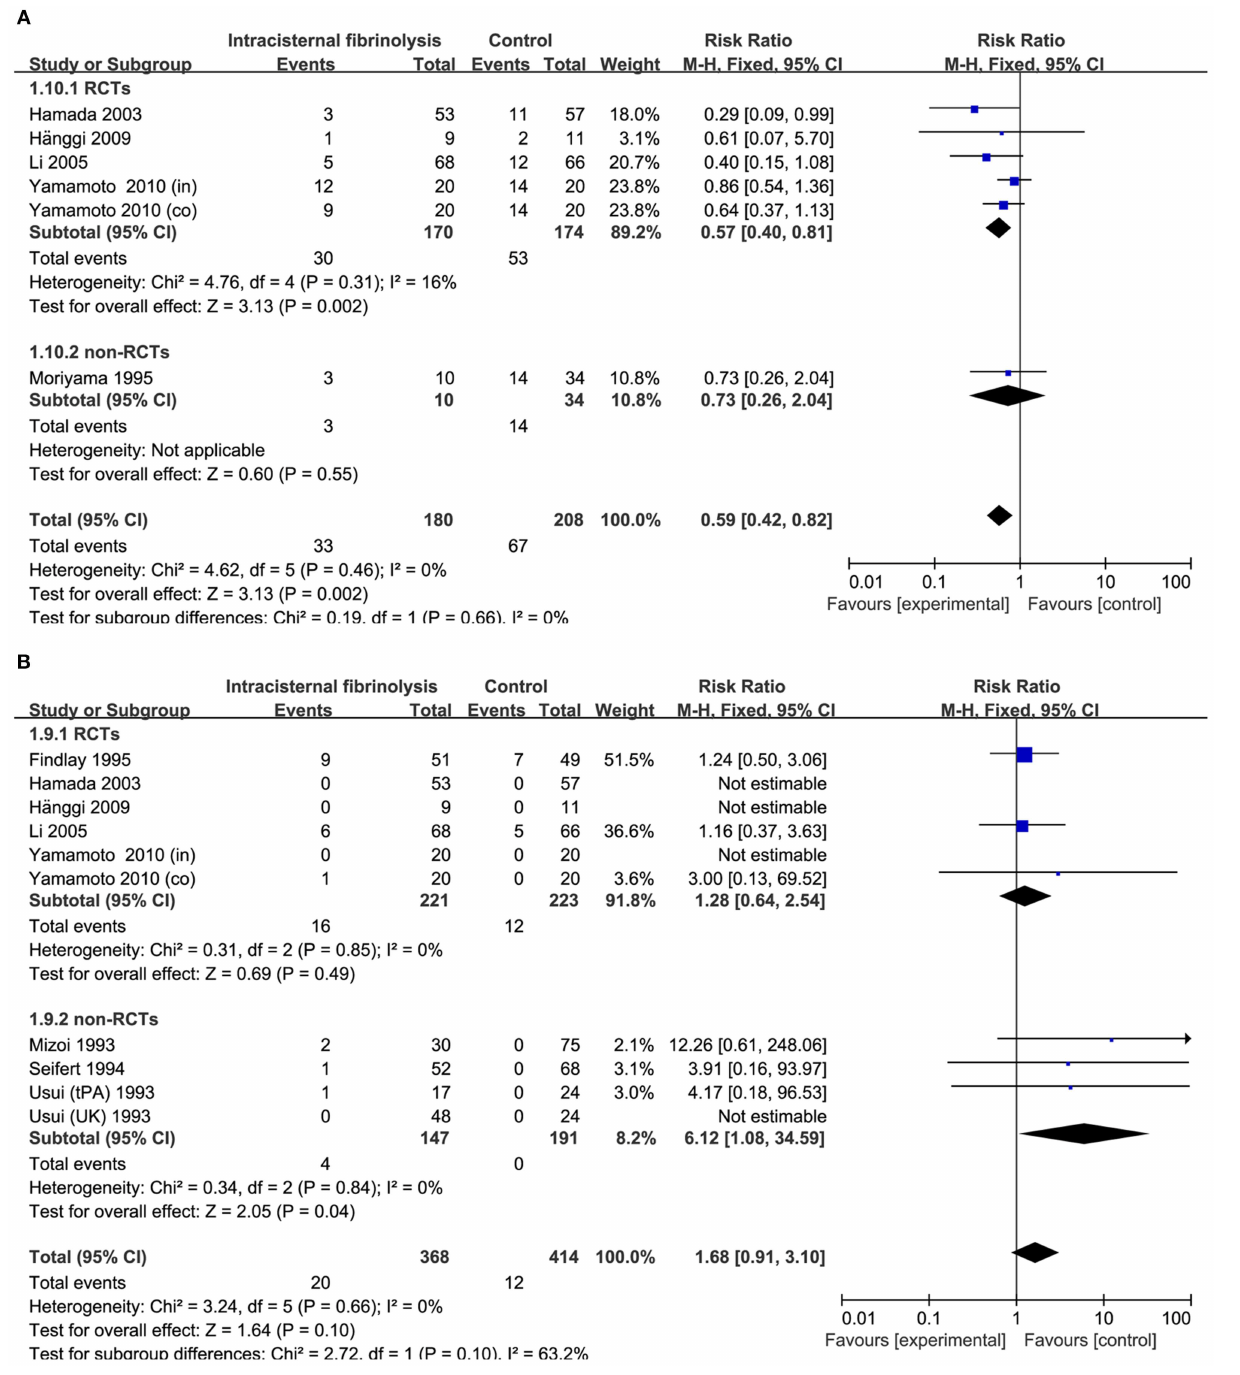
patients with aSAH. There was no significant difference in rebleeding complications between the fibrinolysis and control